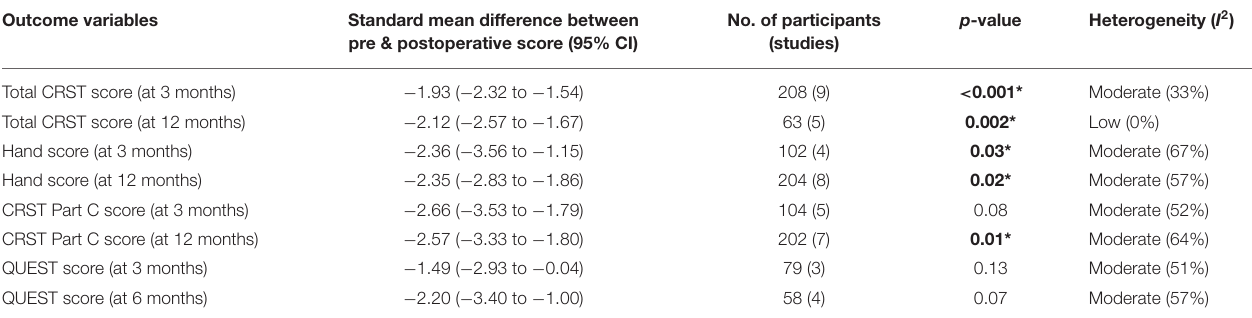
TABLE 4 | Summary of outcomes after meta-analysis. Outcome variables